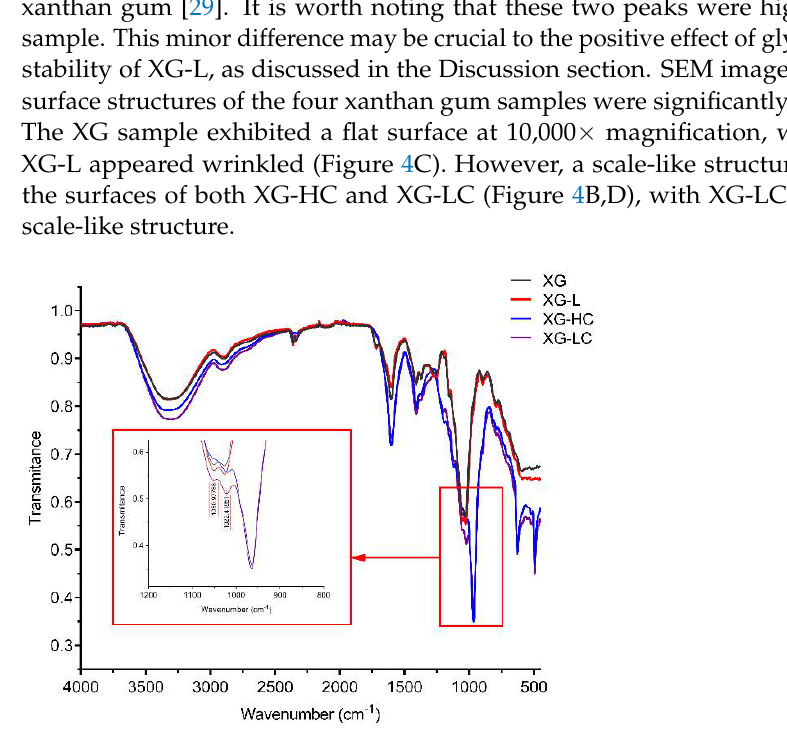
Figure 4. Scanning electron microscopic images of ( A ) XG, ( B ) XG-HC, ( C ) XG-L, and ( D ) XG-LC. XG, natural xanthan gum; XG-HC, natural xanthan gum with a deoxidizer and glyoxal added; XG-L, py- ruvate-free xanthan gum; XG-LC pyruvate-free xanthan gum with a deoxidizer and glyoxal added. 4. Discussion Xanthan gum is an important microbial polysaccharide with various uses. Maintain- ing the viscosity of xanthan gum at high temperatures is of great importance for its appli- cations in the petroleum industry. In this study, we aimed to obtain a xanthan gum prod- uct with enhanced thermal stability through genetic engineering technology combined with stabilizer treatment and to assess the mechanism responsible for the thermal stability